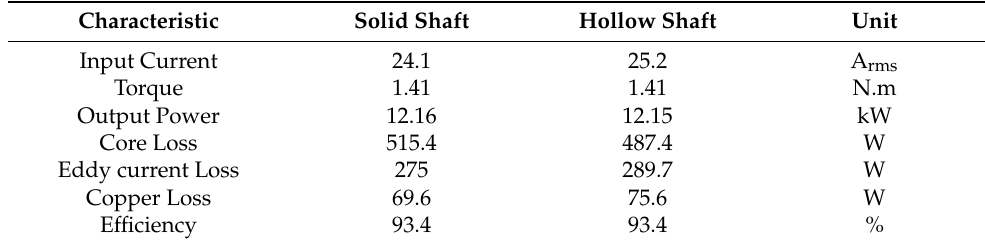
Table 5. High speed motor design specifications according to shaft shape.